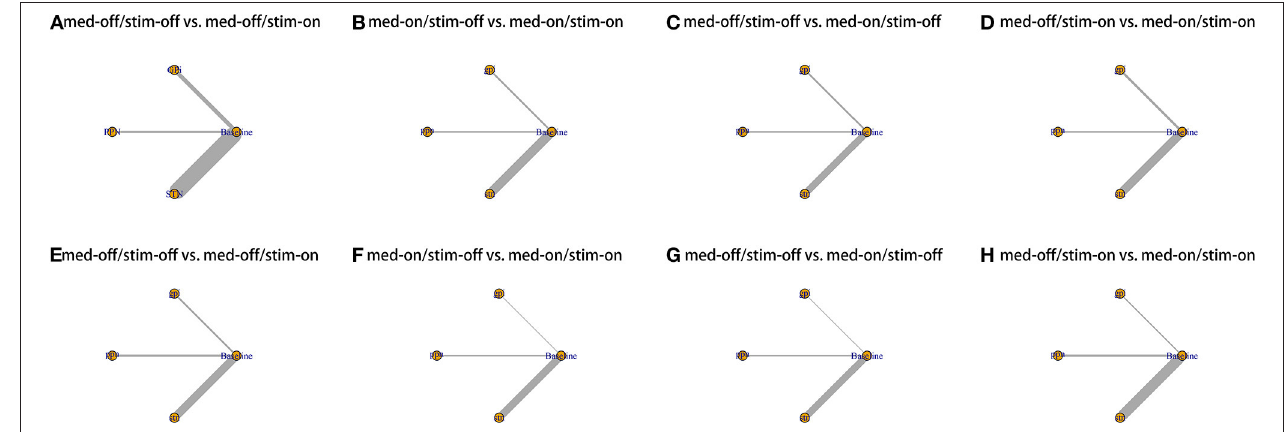
FIGURE 2 | Network plot for all studies. (A) UPDRS III-Gait med-off/stim-off vs. med-off/stim-on. (B) UPDRS III-Gait med-on/stim-off vs. med-on/stim-on. (C) UPDRS III-Gait med-off/stim-off vs. med-on/stim-off. (D) UPDRS III-Gait med-off/stim-on vs. med-on/stim-on. (E) UPDRS III- Total med-off/stim-off vs. med-off/stim-on. (F) UPDRS III- Total med-on/stim-off vs. med-on/stim-on. (G) UPDRS III- Total med-off/stim-off vs. med-on/stim-off. (H) UPDRS III- Total med-off/stim-on vs.